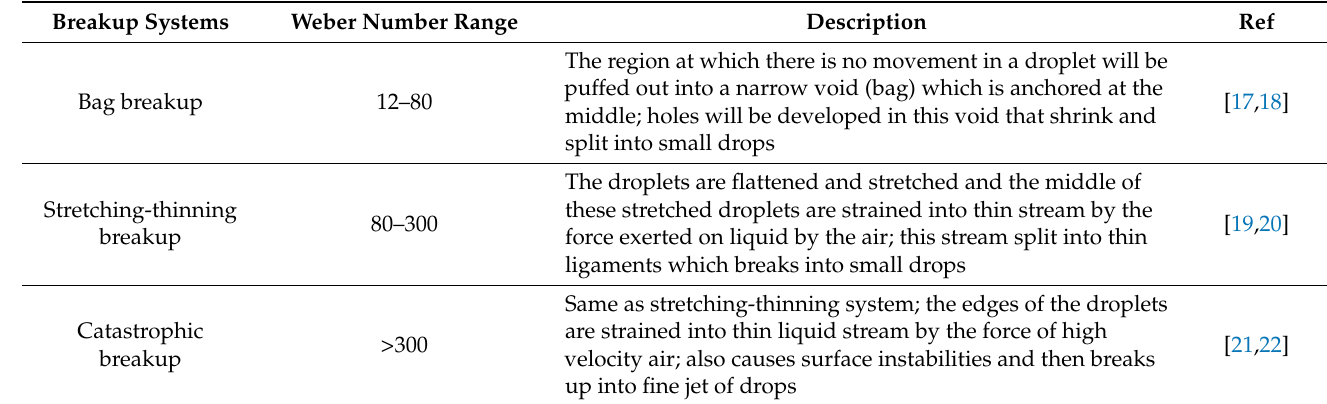
Table 1. Different types of breakup systems experiencing in secondary